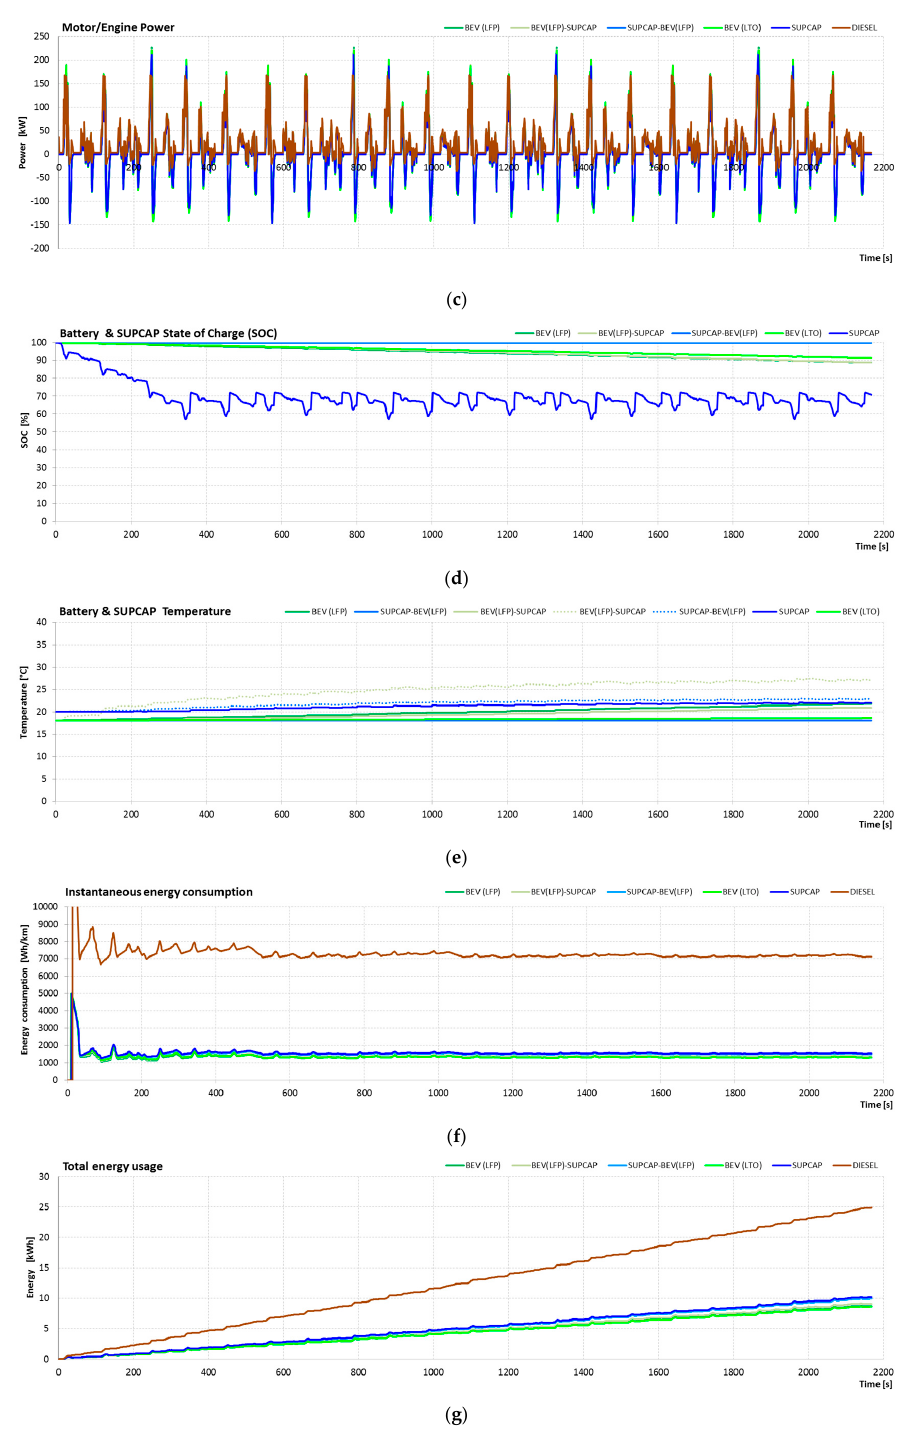
Figure 19. MBC results of simulation tests, where: ( a ) Bus speed during tests (km/h); ( b ) Voltage and Current on DC-link (V), (A); ( c ) Motor/Engine Power (kW); ( d ) Battery & SUPCAP State of Charge (%); ( e ) Battery & SUPCAP temperature ( ◦ C); ( f ) Instantaneous energy consumption (Wh/km); ( g ) Total energy usage